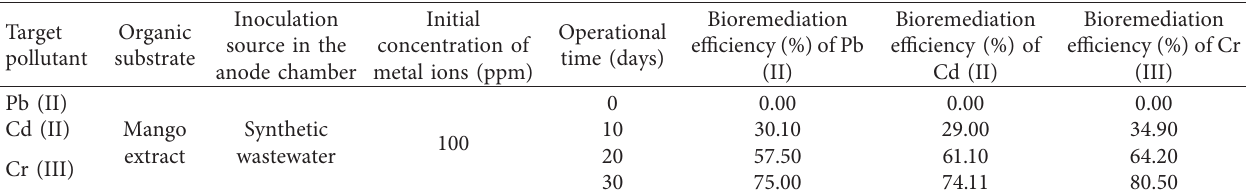
Table 2: Bioremediation trend of the toxic metals via single-chamber MFC fed with mango extract as the organic